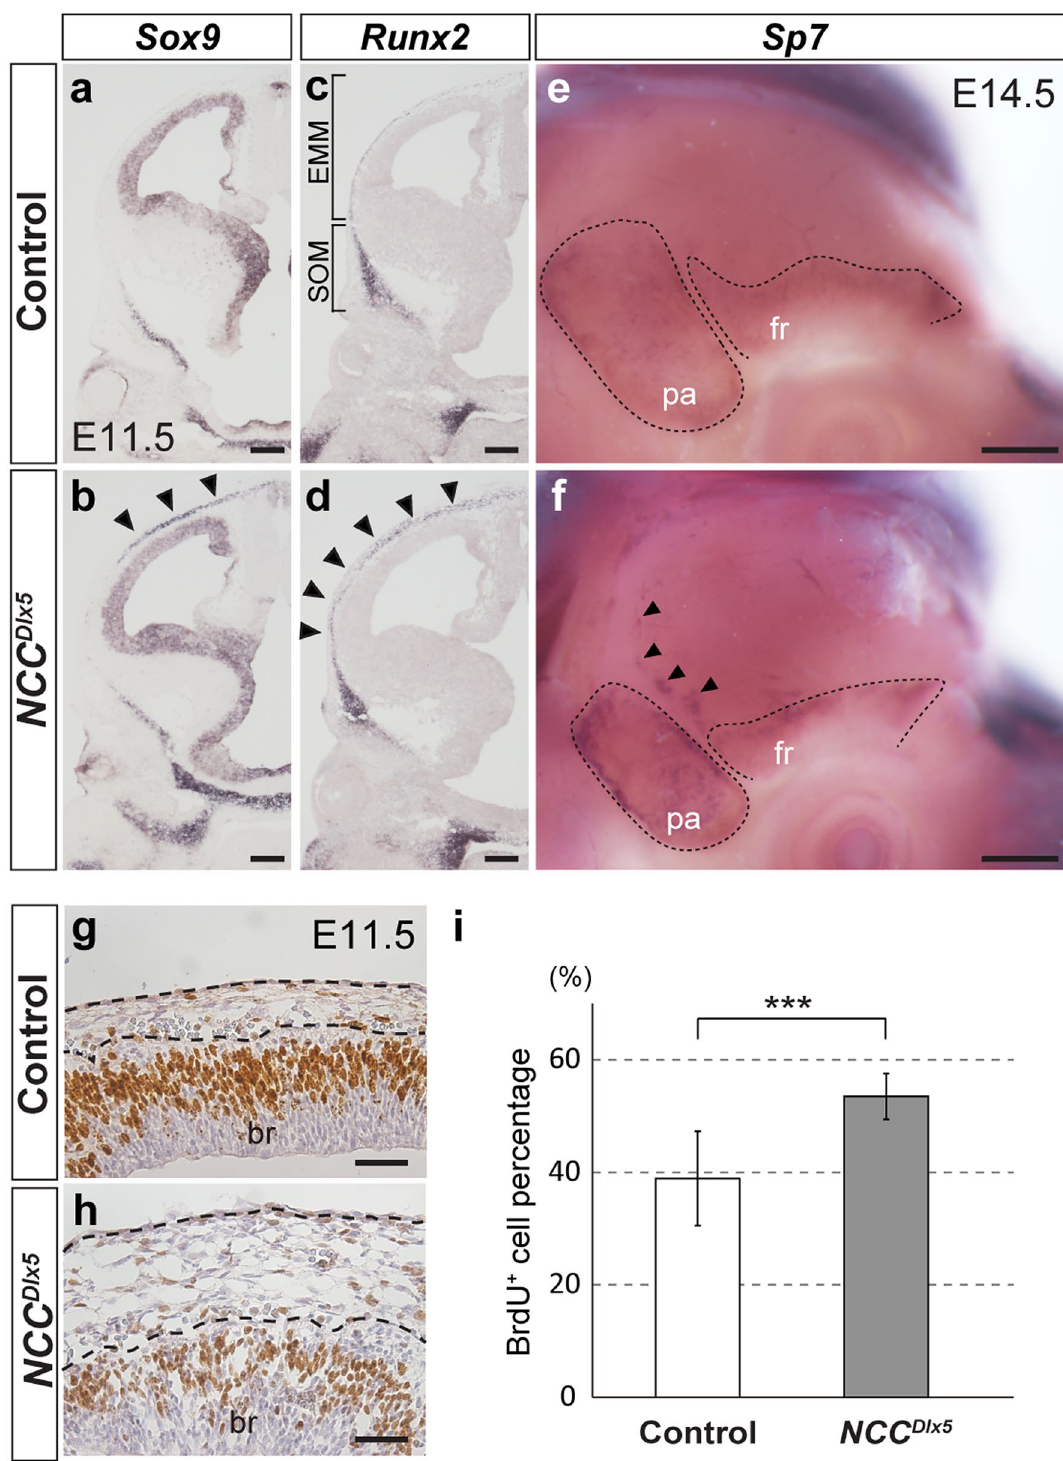
Figure 5. EMM developed the ectopic cartilage and heterotopic bone. ( a – d ) Expression of chondrocyte marker- Sox9 ( a , b ) and osteoblast marker- Runx2 ( c , d ) on frontal sections of E11.5 control ( a , c ) and NCC Dlx5 ( b , d ) by ISH. Arrowheads indicate ectopic expressions of Sox9 ( b ) and Runx2 ( d ) in the EMM of the NCC Dlx5 . ( e, f ) Lateral views of Sp7 expression, an early osteoblast marker and downstream of Runx2 , by WISH on heads of E14.5 control ( e ) and NCC Dlx5 ( f ). Dotted lines in ( e , f ) outline developing frontal and parietal bones. Arrowheads in f point bony islands independent of the frontal bone primordium in the NCC Dlx5 . ( g , h ) BrdU incorporation assay in the EMM at E11.5 of the control ( g ) and the NCC Dlx5 ( h ). BrdU positive cells were counted in the areas between the dashed lines of ( g , h) . ( i ) Statistical analysis of the percentage of BrdU positive cells over the total number of EMM cells (n = 3). Two- tailed t-test,*** p < 0.001. EMM, early migrating mesenchyme; fr, frontal bone; pa, parietal bone; SOM, supraorbital mesenchyme. Scale bars; 200 μm ( a – d ), 500 μm ( e , f ), 50 μm ( g , h